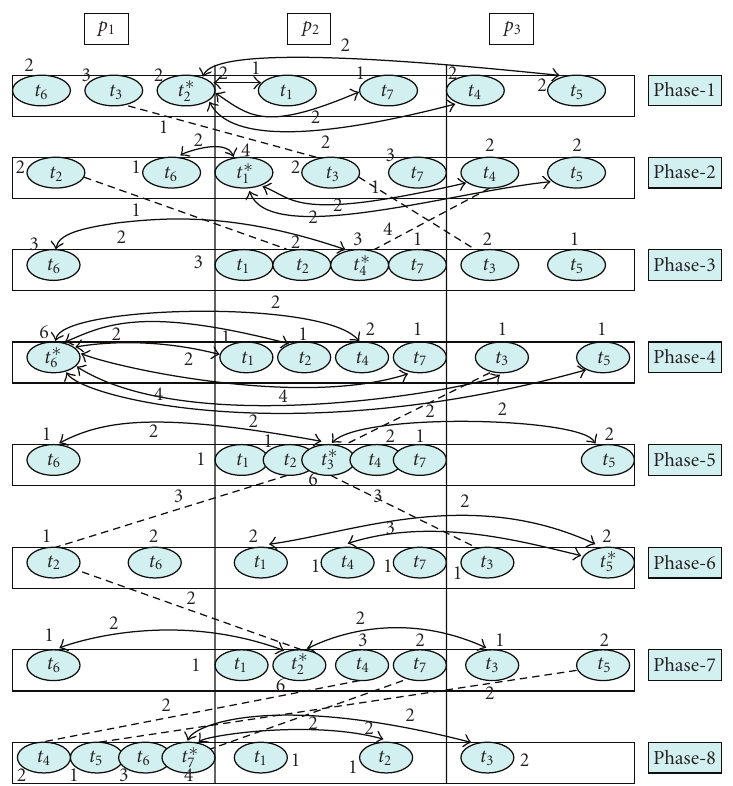
Figure 3: Optimal assignment graph (TCOST =